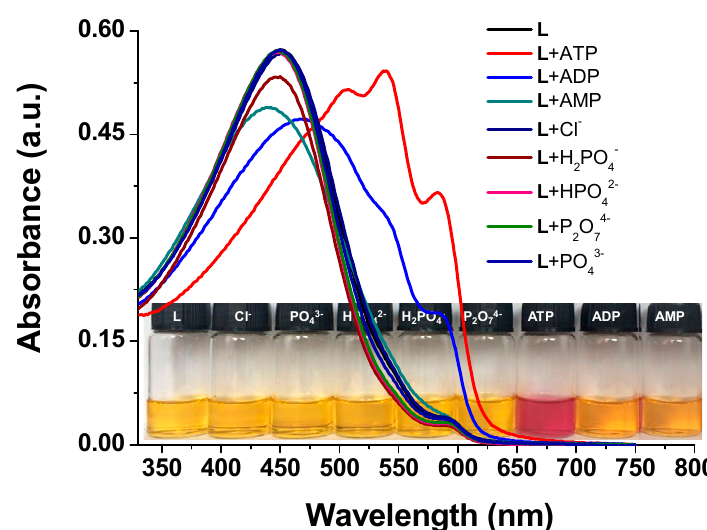
Figure 1. Absorption spectra of L (50 μ M) upon addition of various bio-related sodium salts of anions including ATP, ADP, AMP, Cl − , PO 43 − , HPO 42 − , H 2 PO 4 − and P 2 O 72 − (50 μ M) in water at pH 7.4.